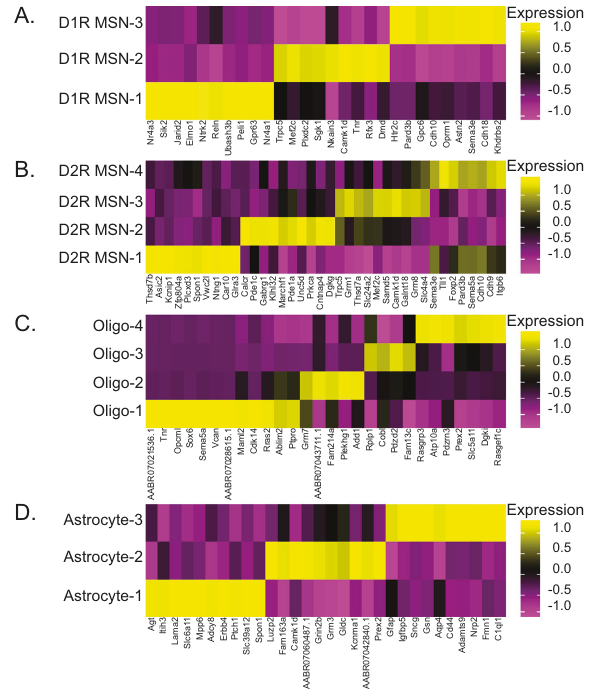
Fig. 4 Cell type identi fi cation. A D1R- and B D2R-expressing neuronal cell types are de fi ned by increased expression of unique genes sets. Similarly, C oligodendrocyte (Oligo) and D astrocyte cell types can be identi fi ed by increased expression of unique sets of marker